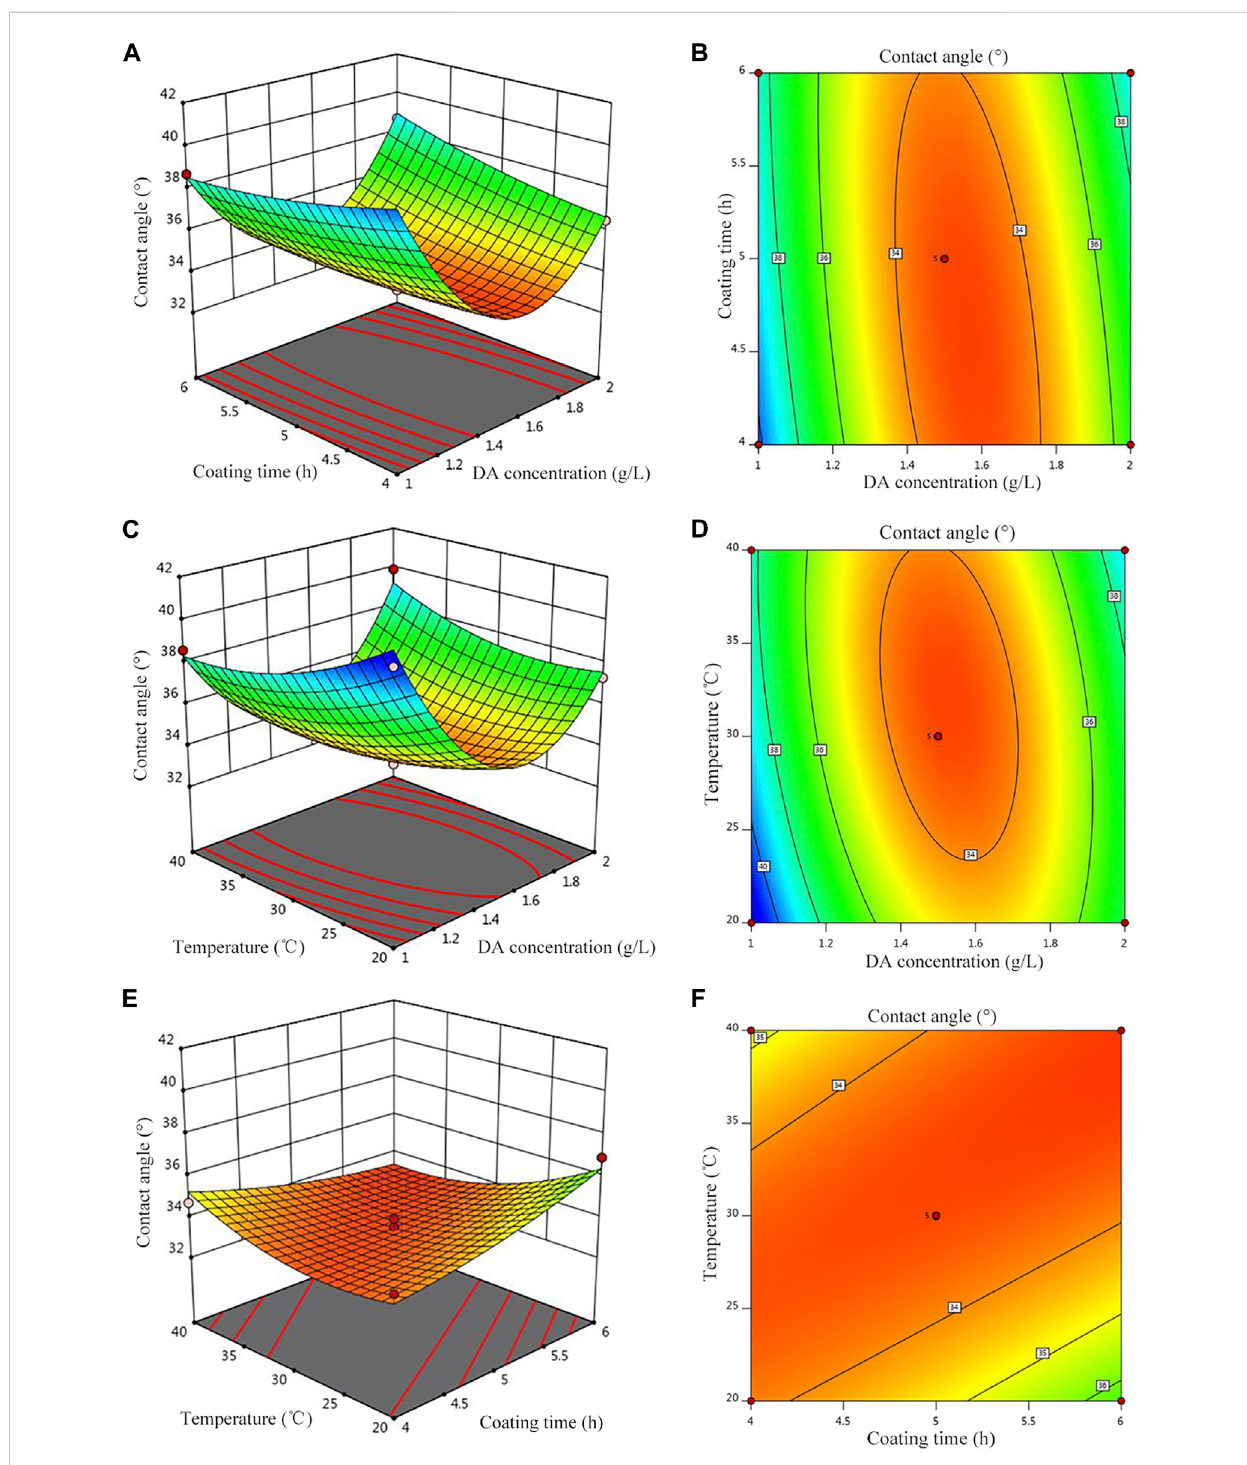
FIGURE 4 Effect of the parameters on the contact angle. (A) Contour of A and B, (B) 3D surfaces of A and B, (C) contour of A and C, (D) 3D surfaces of A and C, (E) Contour of B and C, and (F) 3D surfaces of B and C.